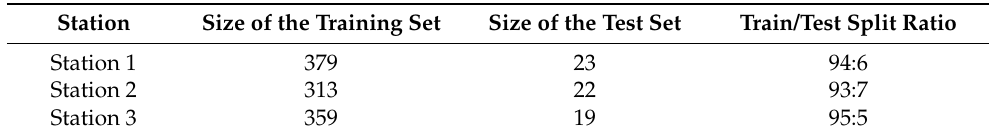
Table 3. Splitting of the labelled dataset into training and test sets for development of the spring freshet model.